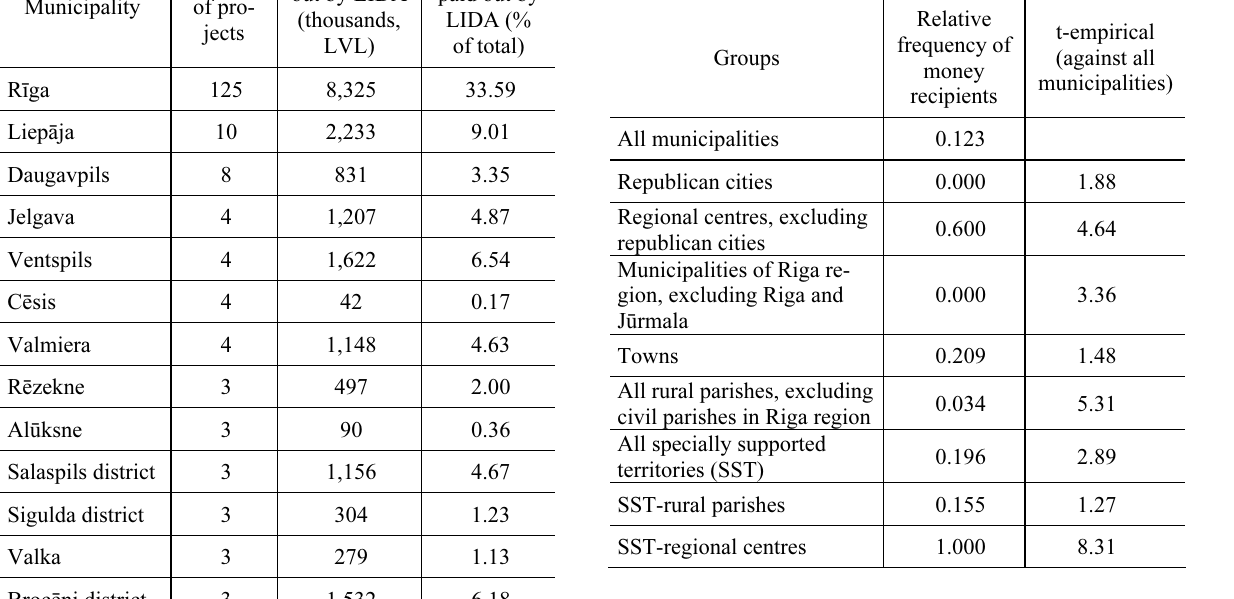
Table 8. Distribution of recipients of the Latvian Rural Support Service Program “Forestry development” in munici-